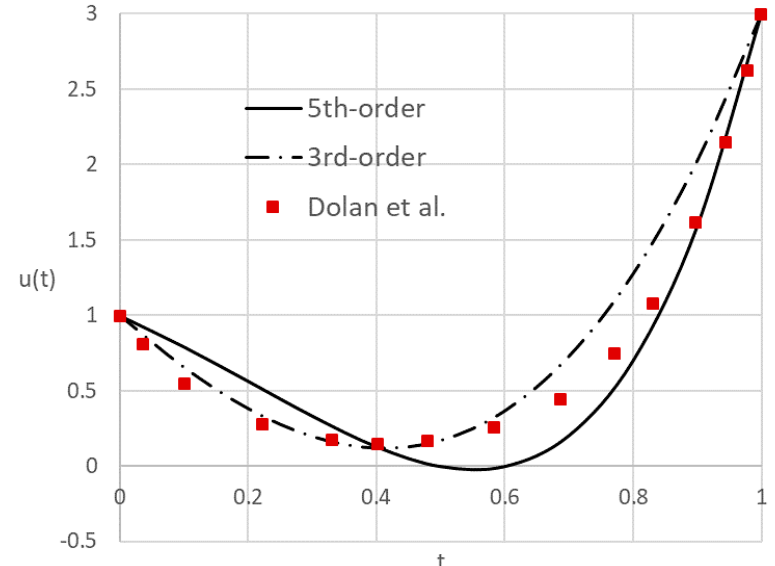
Figure 8. Optimal u ( t ) computed by using 5th order parametrization for problem 3.1. The higher-cost solution with 3rd order parametrization and reported values by Dolan et al. are also shown.